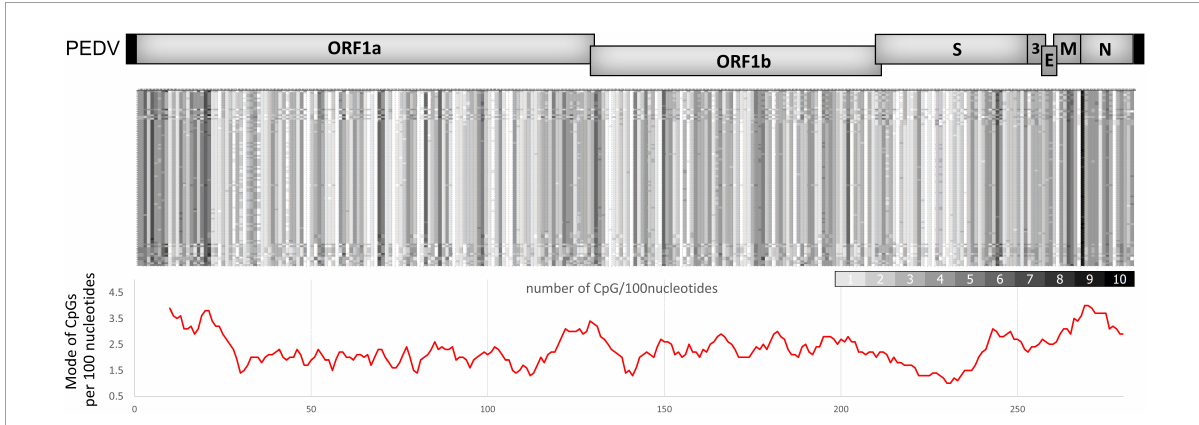
FIGURE2 CpG dinucleotide distribution in porcine epidemic diarrhea virus (PEDV) genomes. (top) Representative complete genome sequences of various PEDV strains were aligned (NCBI accession numbers are listed in the Supplementary material ). The number of CpGs per 100 nucleotides of each segment was analyzed. Results were shown in a heat map (white = 0 CpGs/100-bp, black = 10 CpGs/100-bp). (Bottom) Mode of CpGs per 100-bp from the aligned sequences in each region of the PEDV genomes. The graph below the heat map was plotted by a moving average trend line for every 1,000-bp (10 values of CpGs/100-bp) showing high CpG regions in the early 5 (cid:48) region of ORF1a, the frameshift region between ORF1a and ORF1b, and the structural genes downstream of the spike